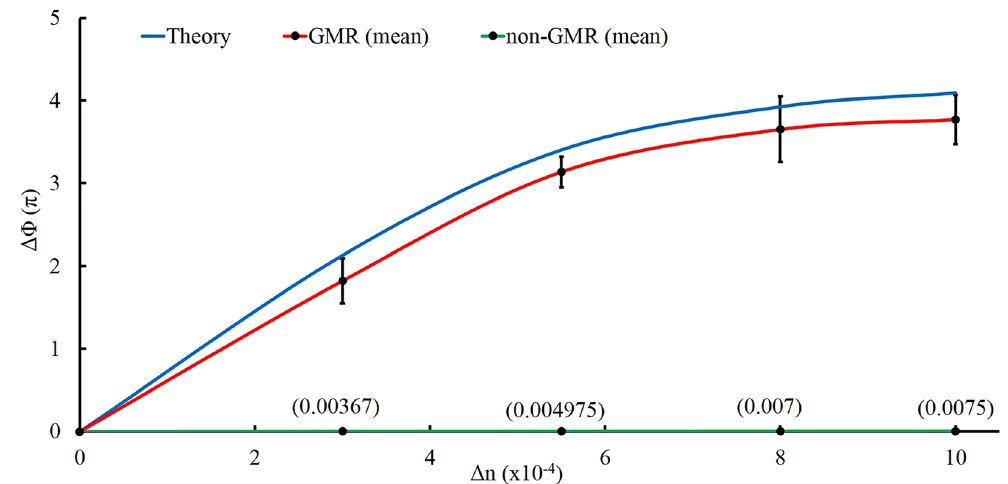
Figure 5. ∆ Φ vs. ∆ n curve. Plot of phase shift ( ∆ Φ ) vs. RI change ( ∆ n) of the sensing medium for the GMR as well as non GMR signal. For the GMR signal both the numerically calculated (blue curve) and experimentally obtained (red curve) curve are shown whereas for the non-GMR signal only experimental curve (green curve that lies almost along the horizontal axis) is shown. The error bars are showing the standard deviations (SD) of the data of many